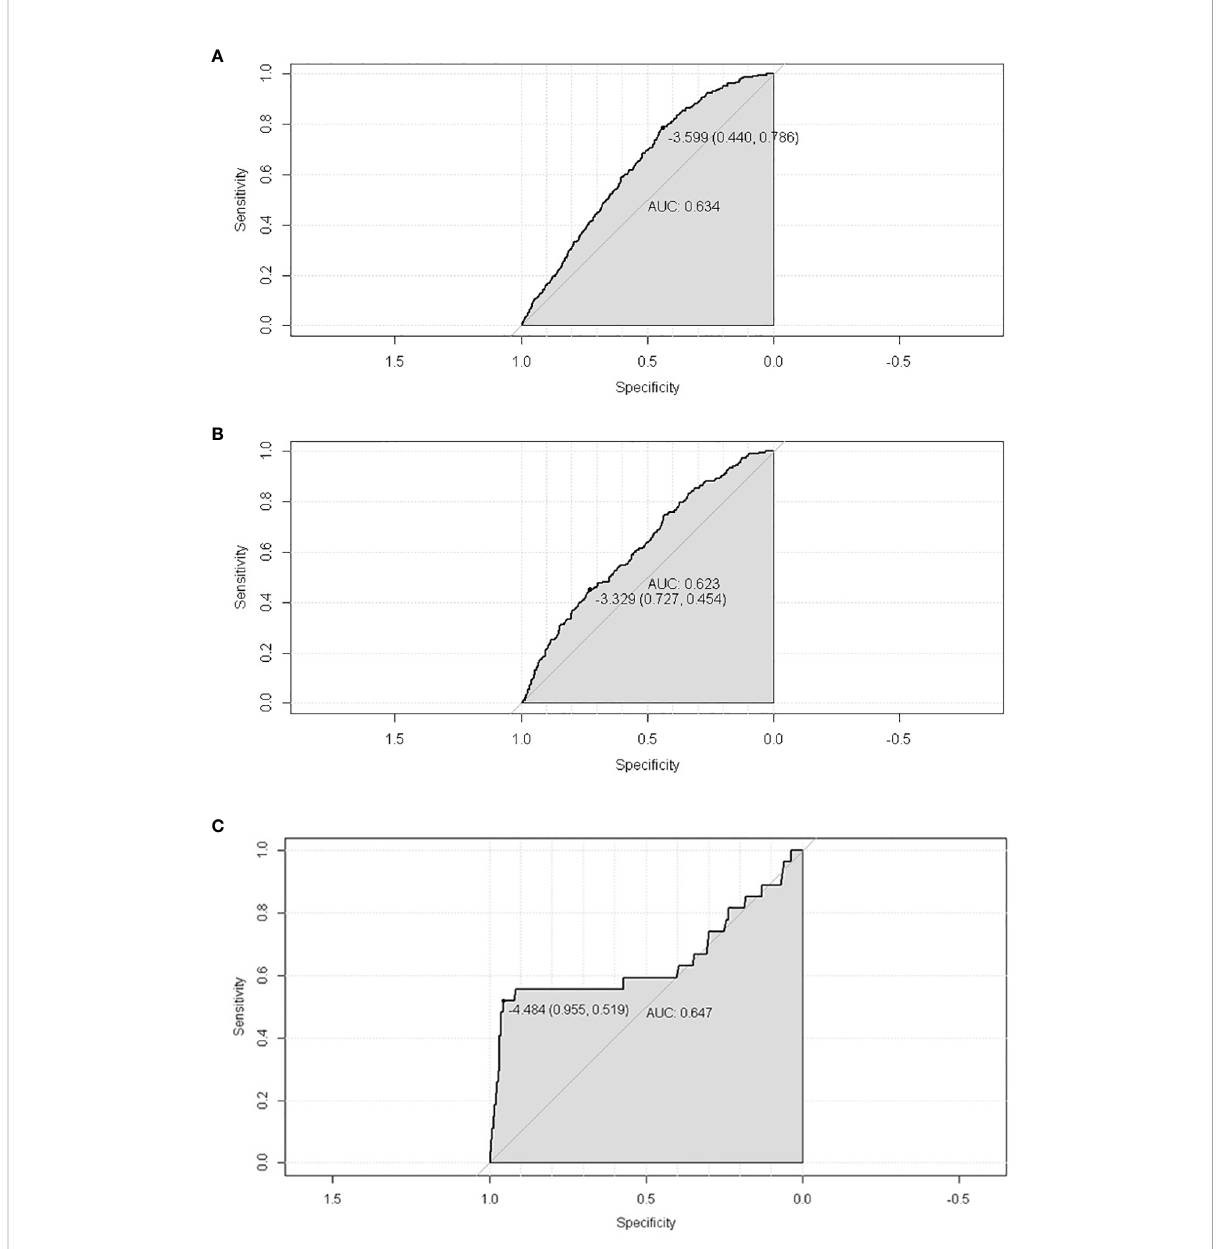
FIGURE 5 The ROC of SPM risk prediction nomogram. (A) trainset; (B) testset; (C) external test